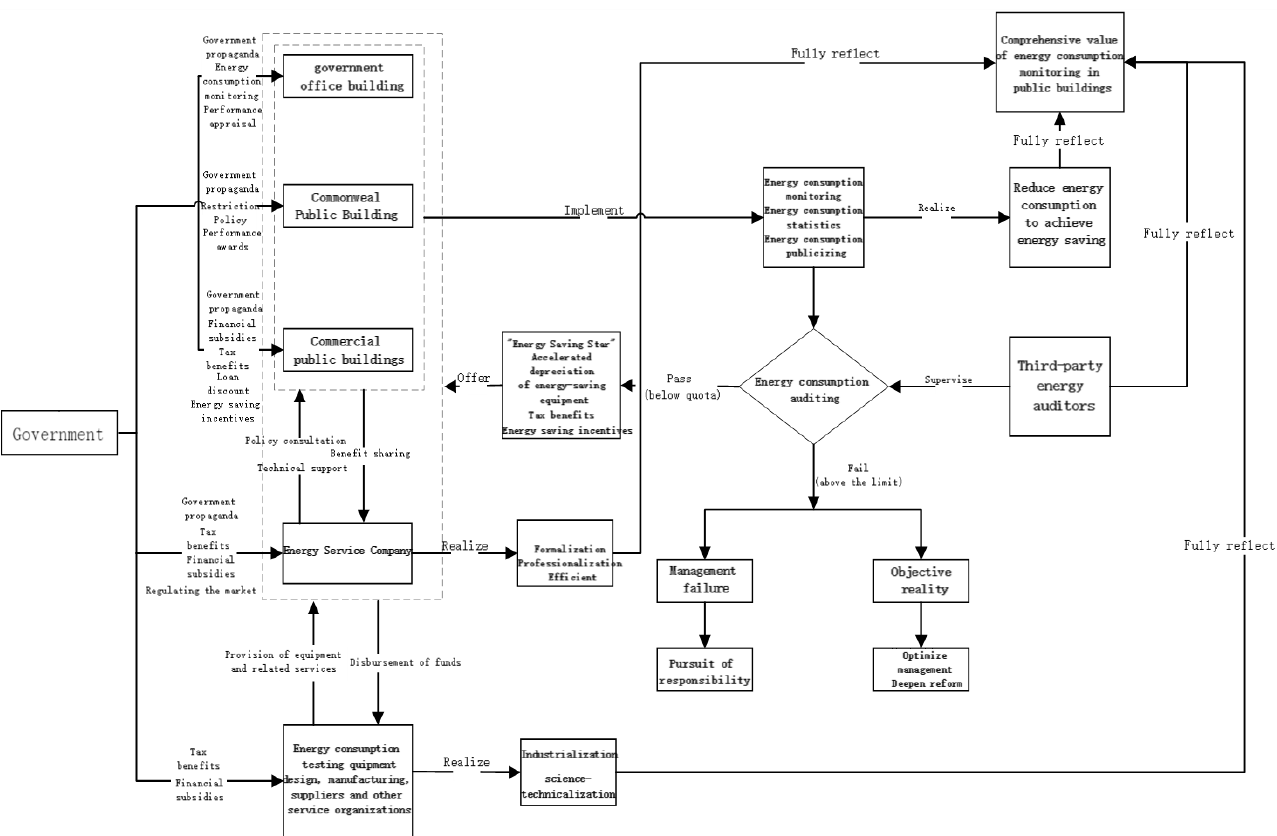
Figure 4. CMECPB incentive mechanism and subsidy design.